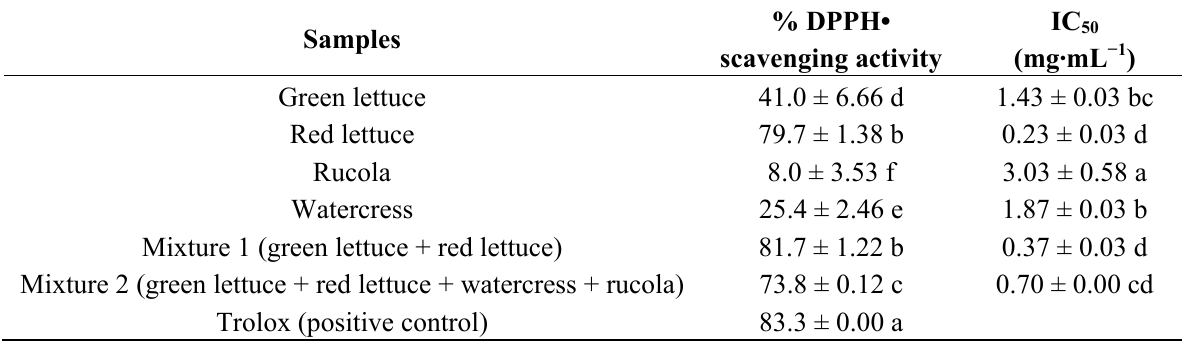
Table 4. Average levels of antioxidant activity of methanolic extracts (1.0 mg·mL − 1 ) from average values 1,2 baby-leaf salads samples, and IC 50